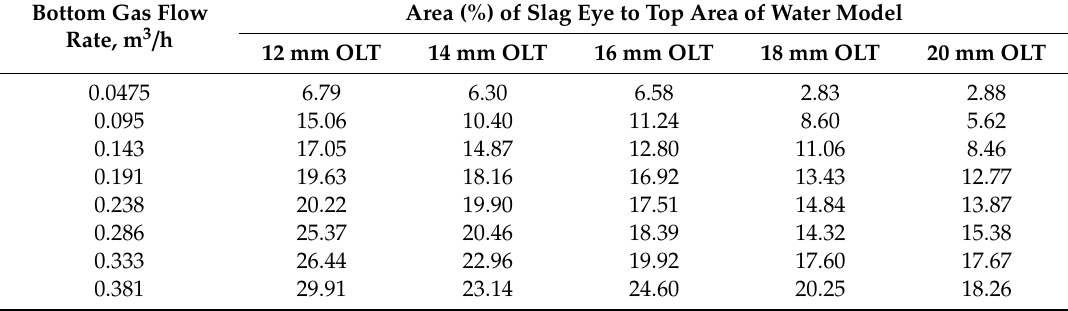
Table 4. The areas of the slag eye at different air flow rate and oil thickness in the water model with a single porous plug.